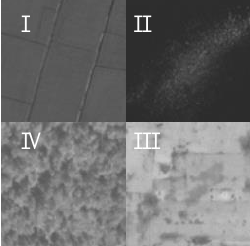
Fig 2 World view-2 synthetic